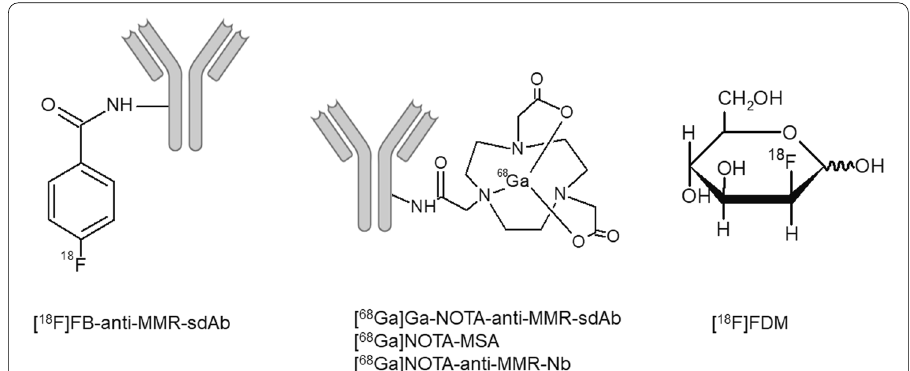
Fig. 3 Structures of representative candidate tracers for the CD206